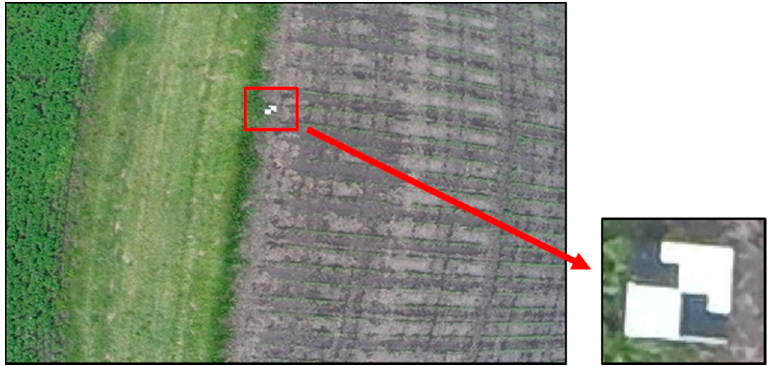
Figure 9. Sample RGB image over the test field with a close-up of one of the targets.